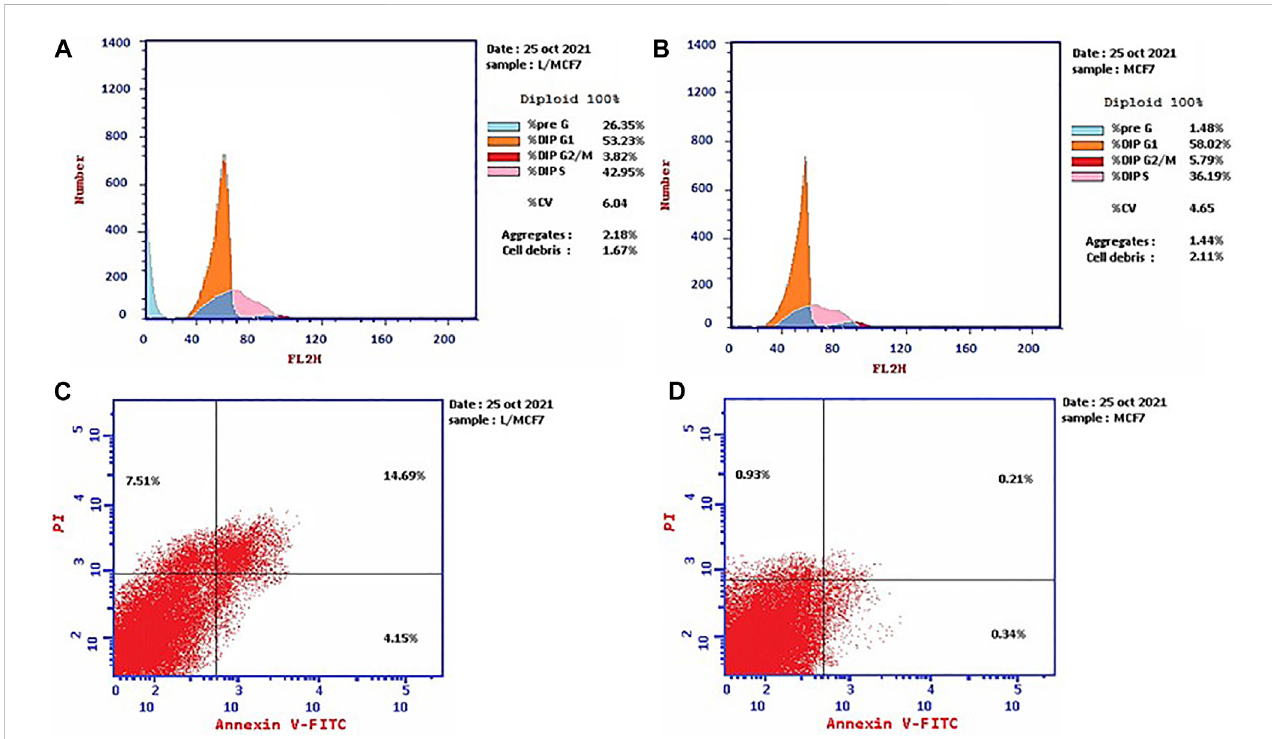
FIGURE 1 Cell cycle distributions of MCF-7 cells (A) treated with EOs obtained from P. cattleianum Sabine leaves compared to (B) untreated, control cells. Percentage of early, late apoptotic, and necrotic cells in MCF-7 cells (C) treated with EOs obtained from P. cattleianum leaves compared to (D) untreated,